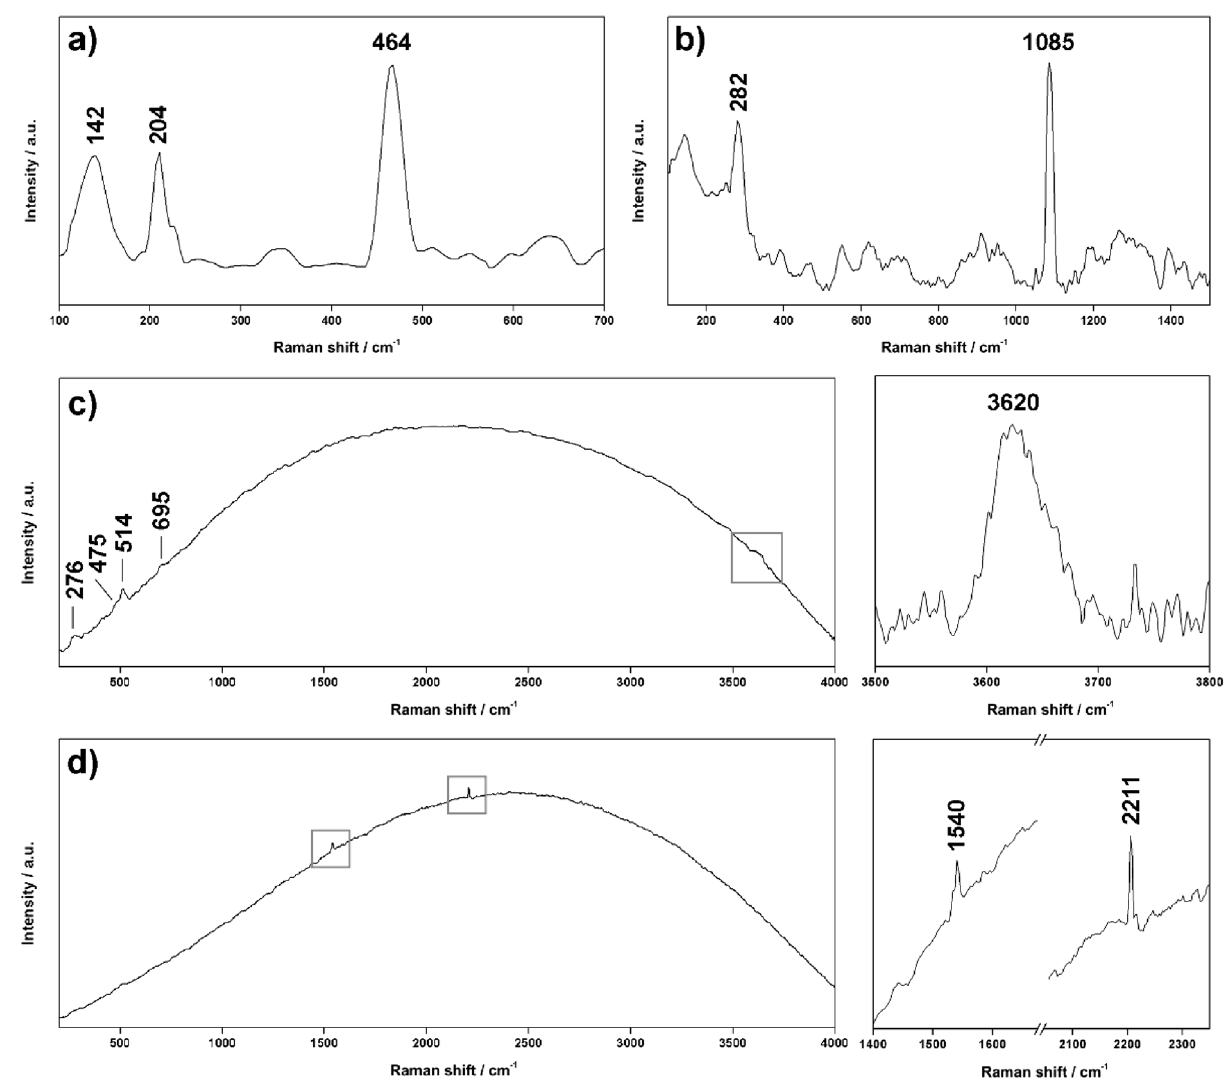
Figure 2. Characteristic Raman spectra of ( a ) quartz, ( b ) calcite, ( c ) mixed feldspar-mica, and ( d ) organics, collected in-situ by the RAD1 system (532 nm). The baseline of spectra a and b has been corrected using dedicated IDAT/SpectPro